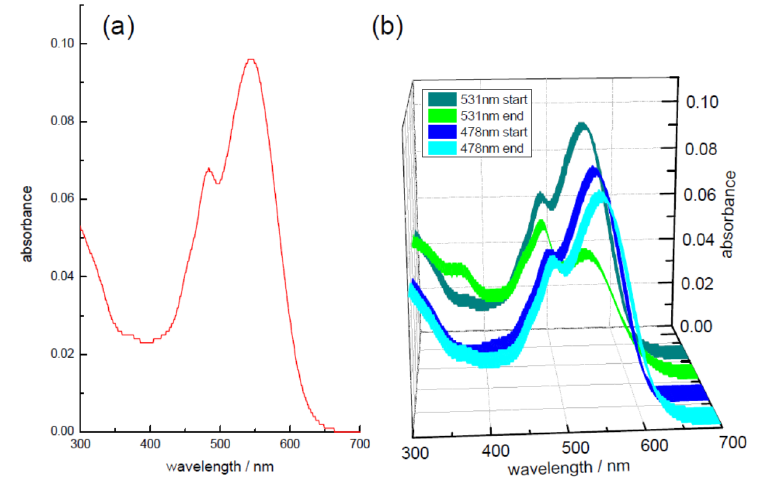
Figure 7. ( a ) absorption spectrum for a freshly made solution of the sample stored for 41 days in (50:50, v:v) methanol: water; ( b ) effect of laser irradiation during the time-resolved measurements, either at 531 nm or 478 nm on the same sample.